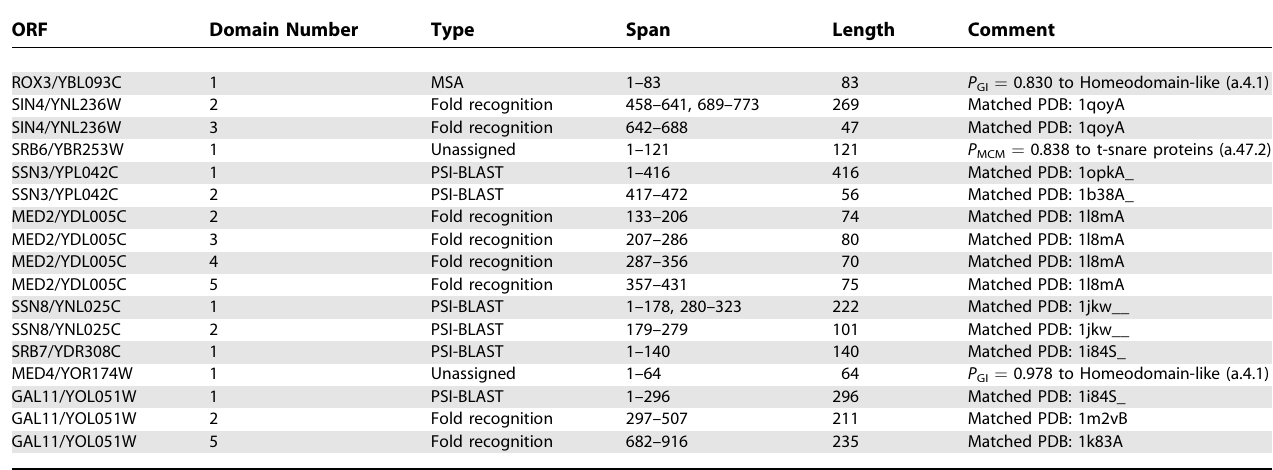
Table 4. Predicted Domains and Structures for Components of the Mediator Complex ORF Domain